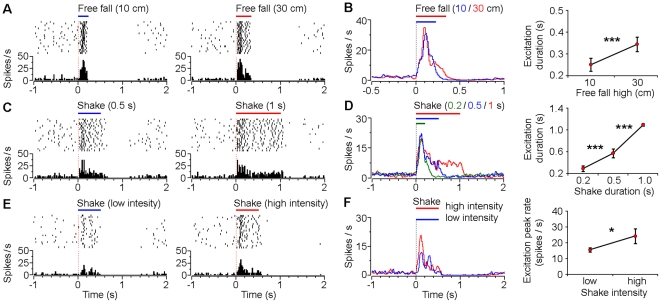
Responses of VTA type-3 dopaminegic-like neurons to different durations and intensities of fearful events.(A) Peri-event rasters (1-20 trials) and histograms of one example type-3 neuron in response to 10 cm (left) and 30 cm (right) free fall events. (B) Smoothed population average peri-event histograms (left) and offset excitation latencies (right) of type-3 neurons in response to 10 cm (blue line; n = 8) and 30 cm (red line; n = 10) free fall events. (C) Peri-event rasters and histograms of the same neuron (as shown in A) in response to 0.5 sec (left) and 1 sec (right) shake events. (D) Smoothed population average peri-event histograms (left) and offset excitation latencies (right) of type-3 neurons in response to 0.2 sec (green line; n = 10), 0.5 sec (blue line; n = 9), and 1 sec (red line; n = 7) shake events. (E) Peri-event rasters and histograms of another type-3 neuron in response to low- (left) and high-intensity (right) shake events. (F) Smoothed population average peri-event histograms (left) and offset excitation peak firing rates (right) of type-3 neurons in response to low- (blue line; n = 5) and high-intensity (red line; n = 5) shake events. Error bars, s.d.; *P<0.05, ***P<10-5, Student's t-test.